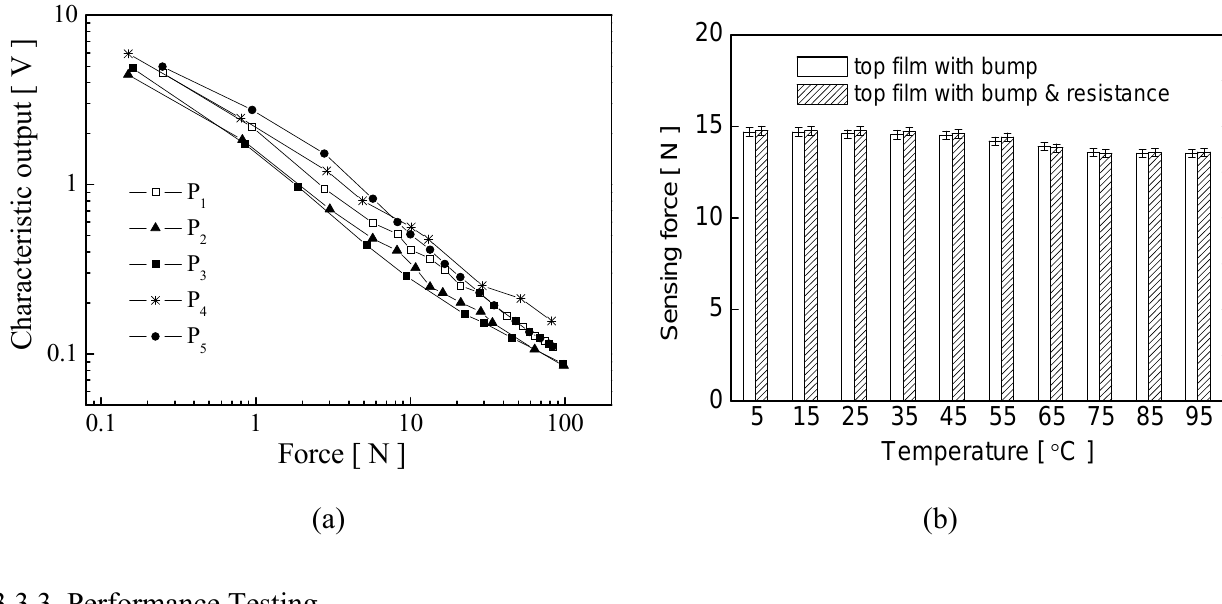
Figure 9. Characteristics output of flexible electronics sensors. (a) Voltage versus force at an operating frequency of 1 kHz at various pixels, and (b) steady-state output voltage response of the membrane with a bump and with bump and resistance layers at various